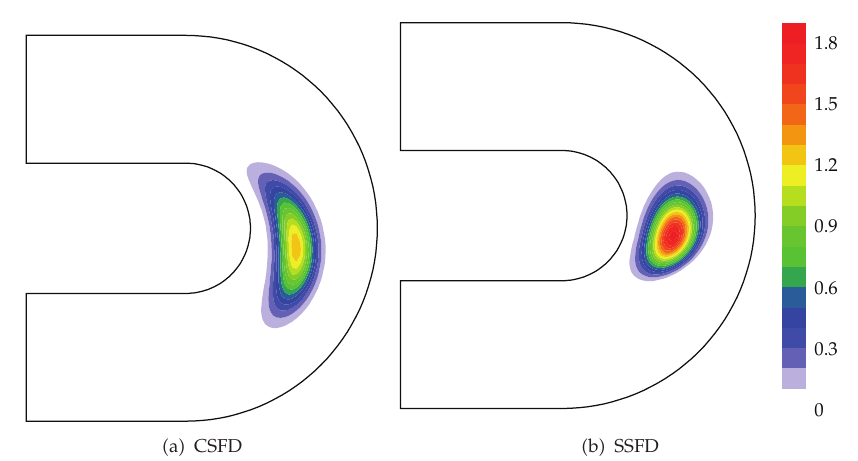
Figure 9: Concentration distribution in Rozovski’s channel at t (cid:9) 4s.